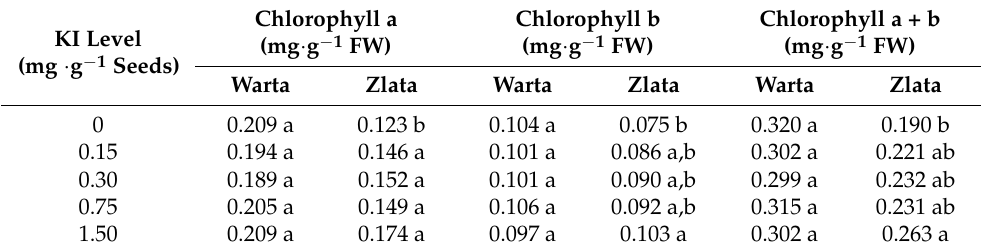
Table 3. Chlorophyll content in radish seedlings biofortified with iodine. KI Level